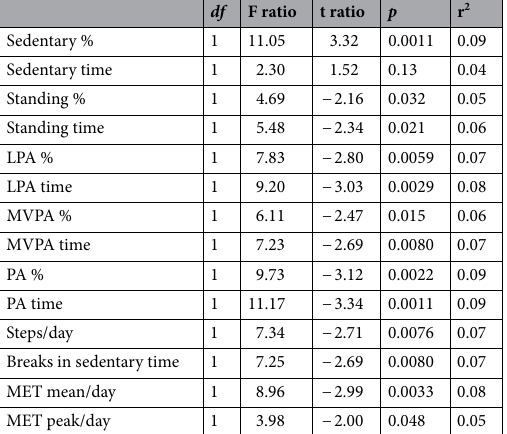
df F ratio t ratio